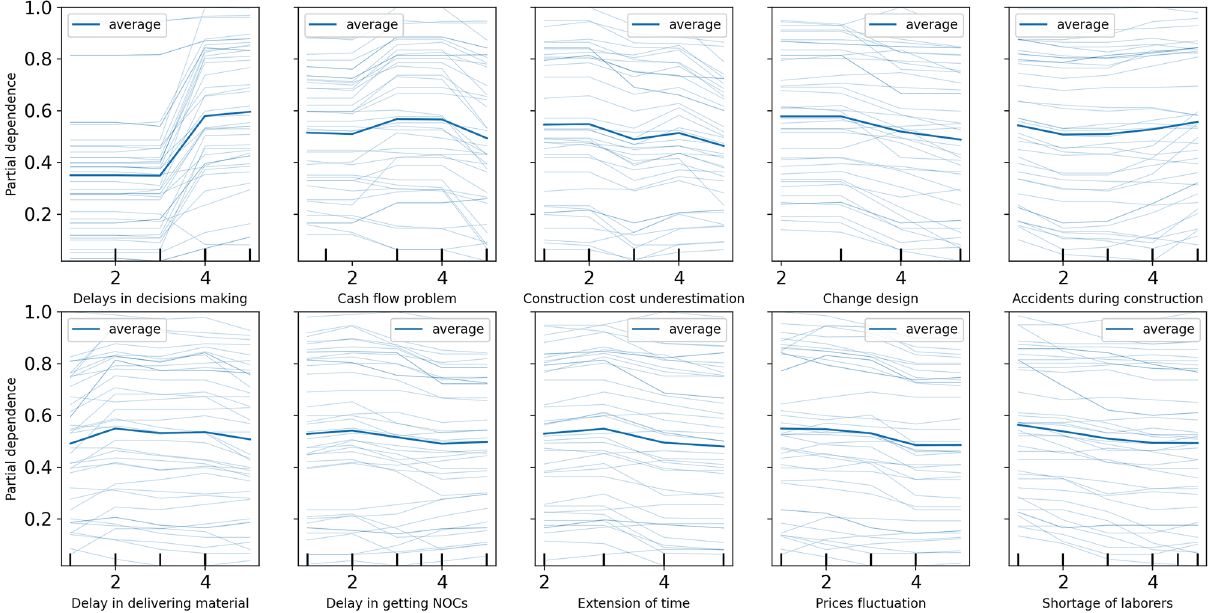
Figure 6. The result of the sensitivity analysis from the partial dependency plot tool for the ten most important